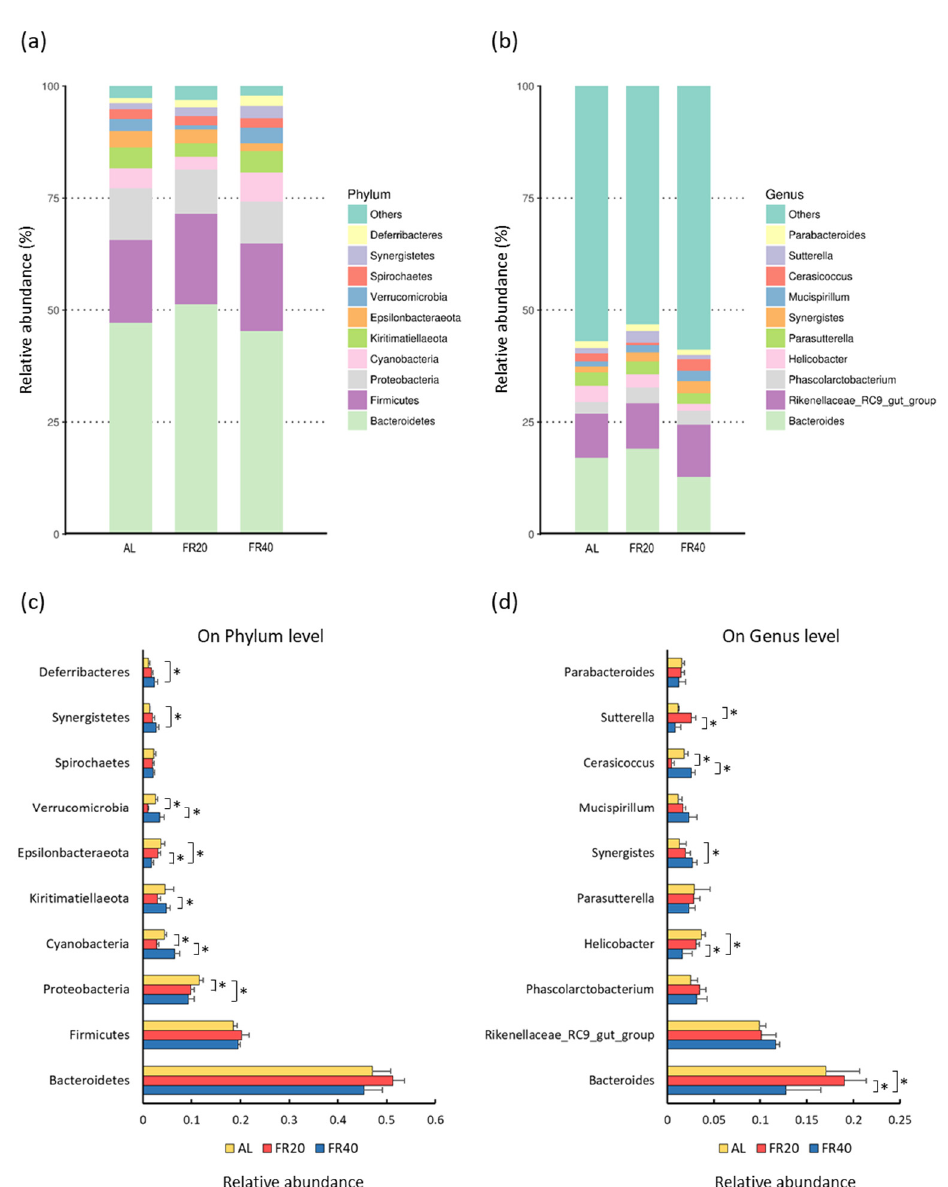
Figure 4. Composition of the top 10 microorganisms in the cecum of the hens among normal feeding and restriction feeding group at ( a ) phylum level and ( b ) genus level. A comparison of the relative abundance (percentage of sequence) of ( c ) the main bacterial phyla and ( d ) the main bacterial genera is shown. The calculation is based on the average relative abundance of the main bacterial communities. * p < 0.05 compare the data between FR20 and 40 and FR20 or FR40 and AL group. AL: ad libitum with basal diet; FR20: basal diet with 20% feed restriction; FR40: basal diet with 40% feed restriction.